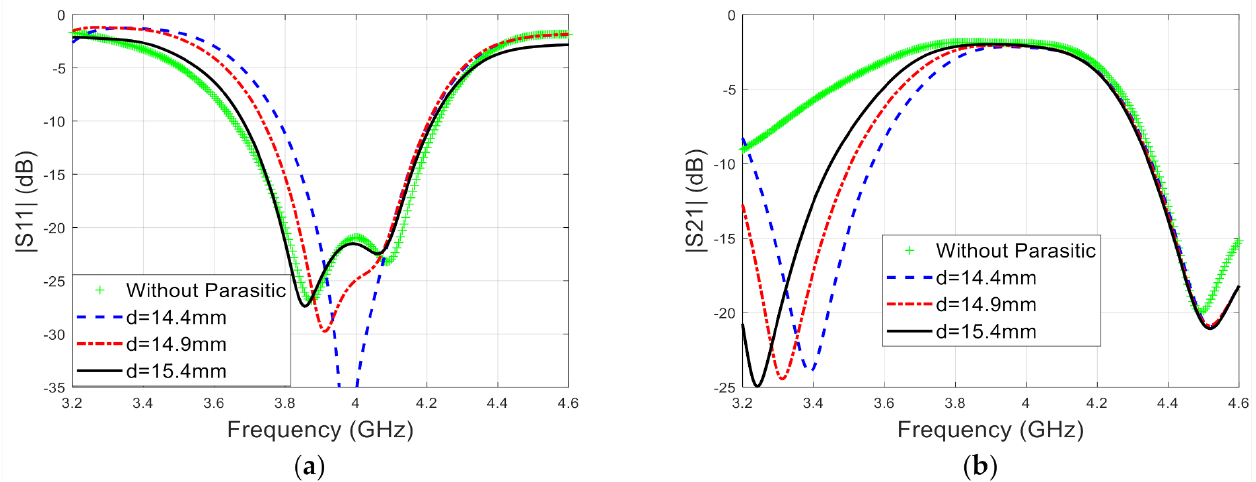
Figure 9. Simulated scattering parameters of the proposed SL-MMR based microwave filter with the parasitic elements at different values of parasitic element arm length d: ( a ) reflection coefficient; and ( b ) the transmission